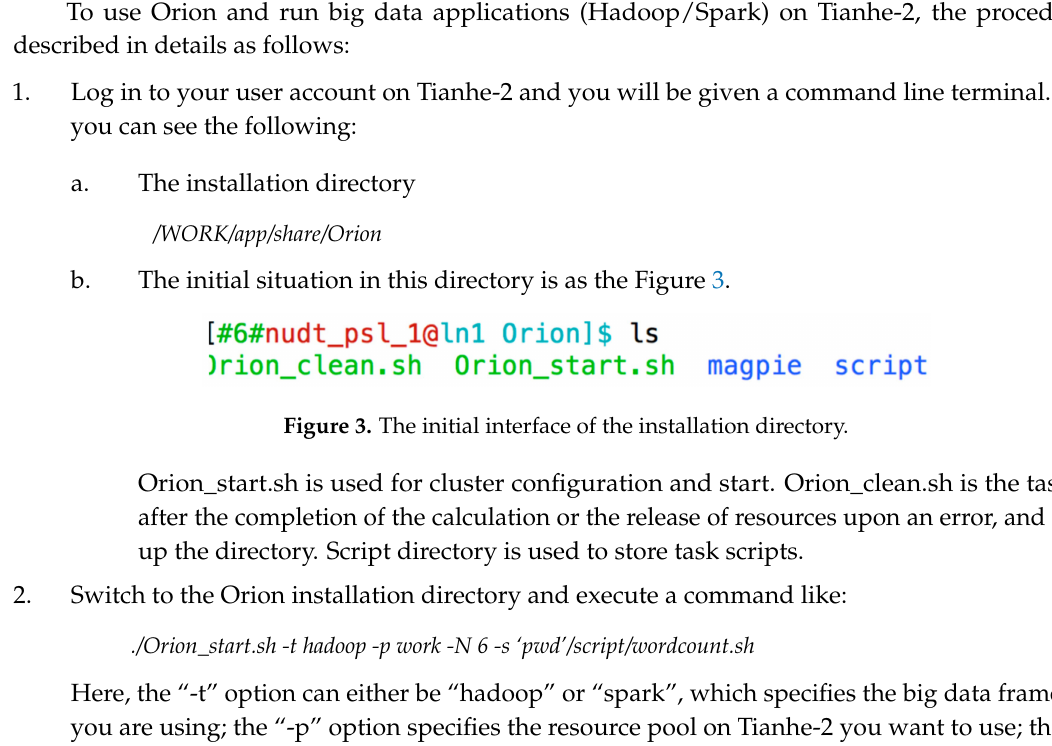
Figure 3. The initial interface of the installation directory.